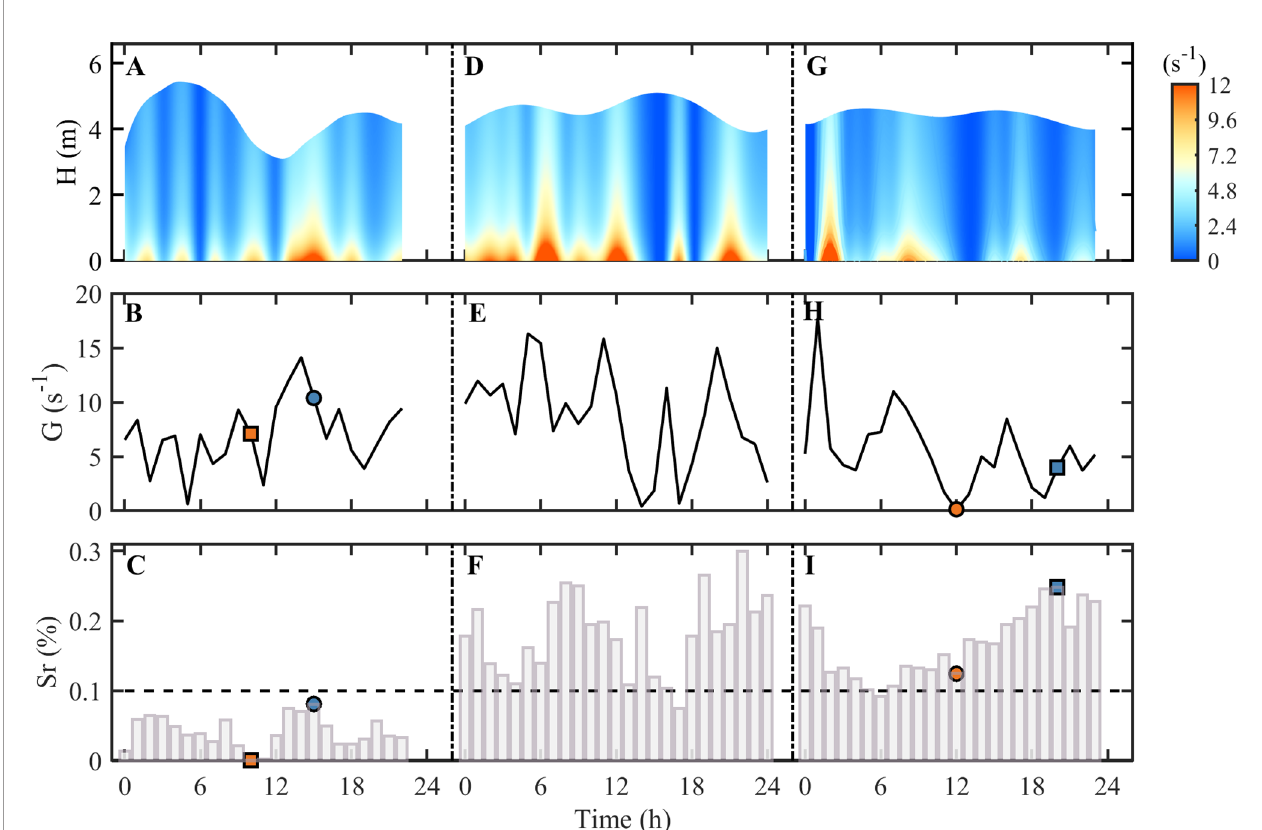
FIGURE 4 | Vertical and temporal variation of (A, D, G) G (s -1 ), and temporal variation of (B, E, H) G in the bottom layer (s -1 ), (C, F, I) Sr (%); ( A – C : spring tide; D – F : middle tide; G – I : neap tide). In the fi gures, the black dashed line ( Sr = 0.1%) indicates the critical value of salinity strati fi cation, the blue and orange dots represent the high shear rate with high SSC and the low shear rate with low SSC , respectively; and the blue and orange squares represent the high salinity strati fi cation and low salinity strati fi cation,